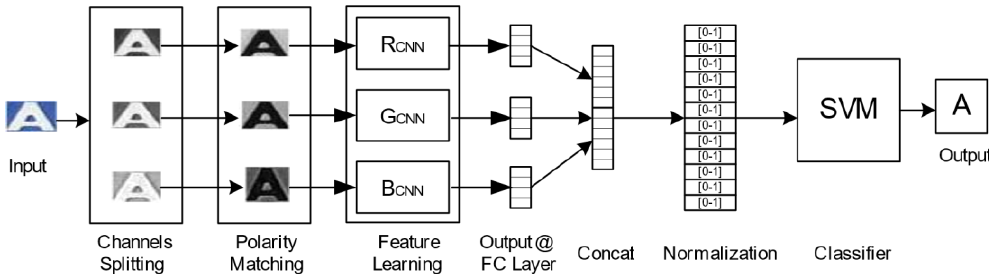
Figure 11. Proposed architecture for multinational vehicles license plate character recognition.